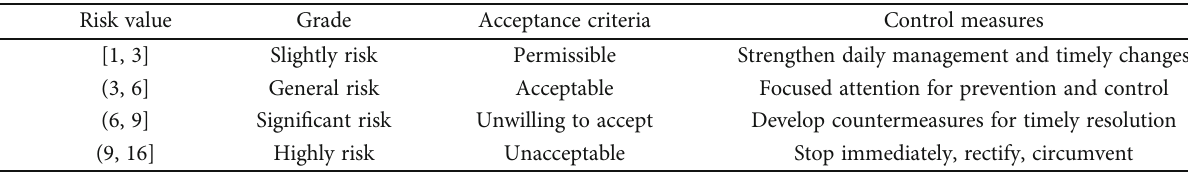
Table 5: Grading criteria for risk.